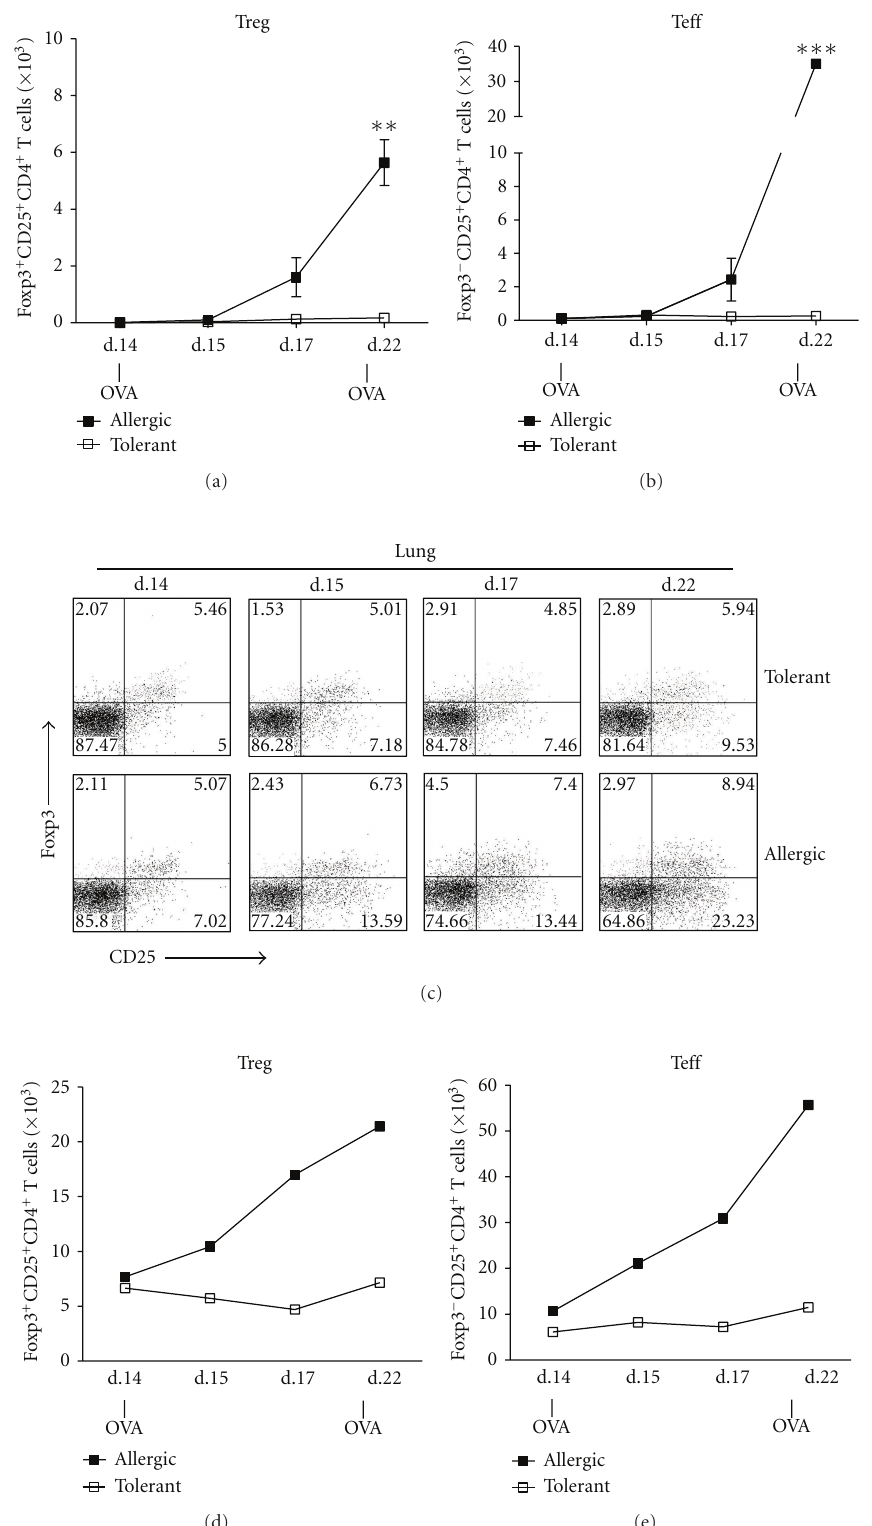
Figure 3: Regulatory T cells accumulate in the airways of allergic but not tolerant mice. Time course of (a) CD4 + CD25 + Foxp3 + (Treg) and (b) CD4 + CD25 + Foxp3 − (Te ff ) cells number in the BAL of allergic and tolerant mice. (c) Frequency and (d) number of CD4 + CD25 + lung cells expressing or not Foxp3. Pooled cells from three mice recovered from BAL and lung were stained for CD4, CD25, and Foxp3 and gated in CD4-positive cells. Values in (a) and (b) represent the means ± SEM for groups of three mice and are representative of two experiments. The data in (c) show a representative experiment of two. Significant di ff erences ∗∗ P < 0 . 01, ∗∗∗ P < 0 . 001 are related to tolerant